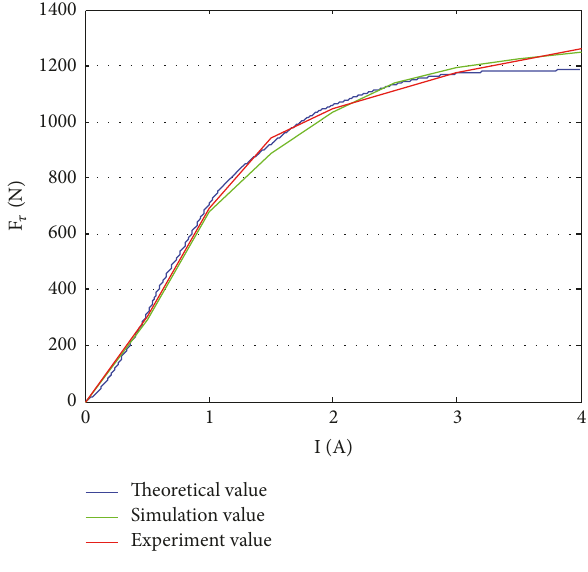
Figure 23: Shear stress of the MRF